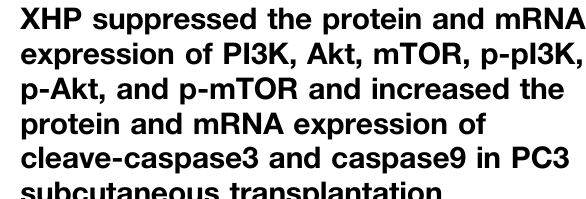
Frontiers in Pharmacology |